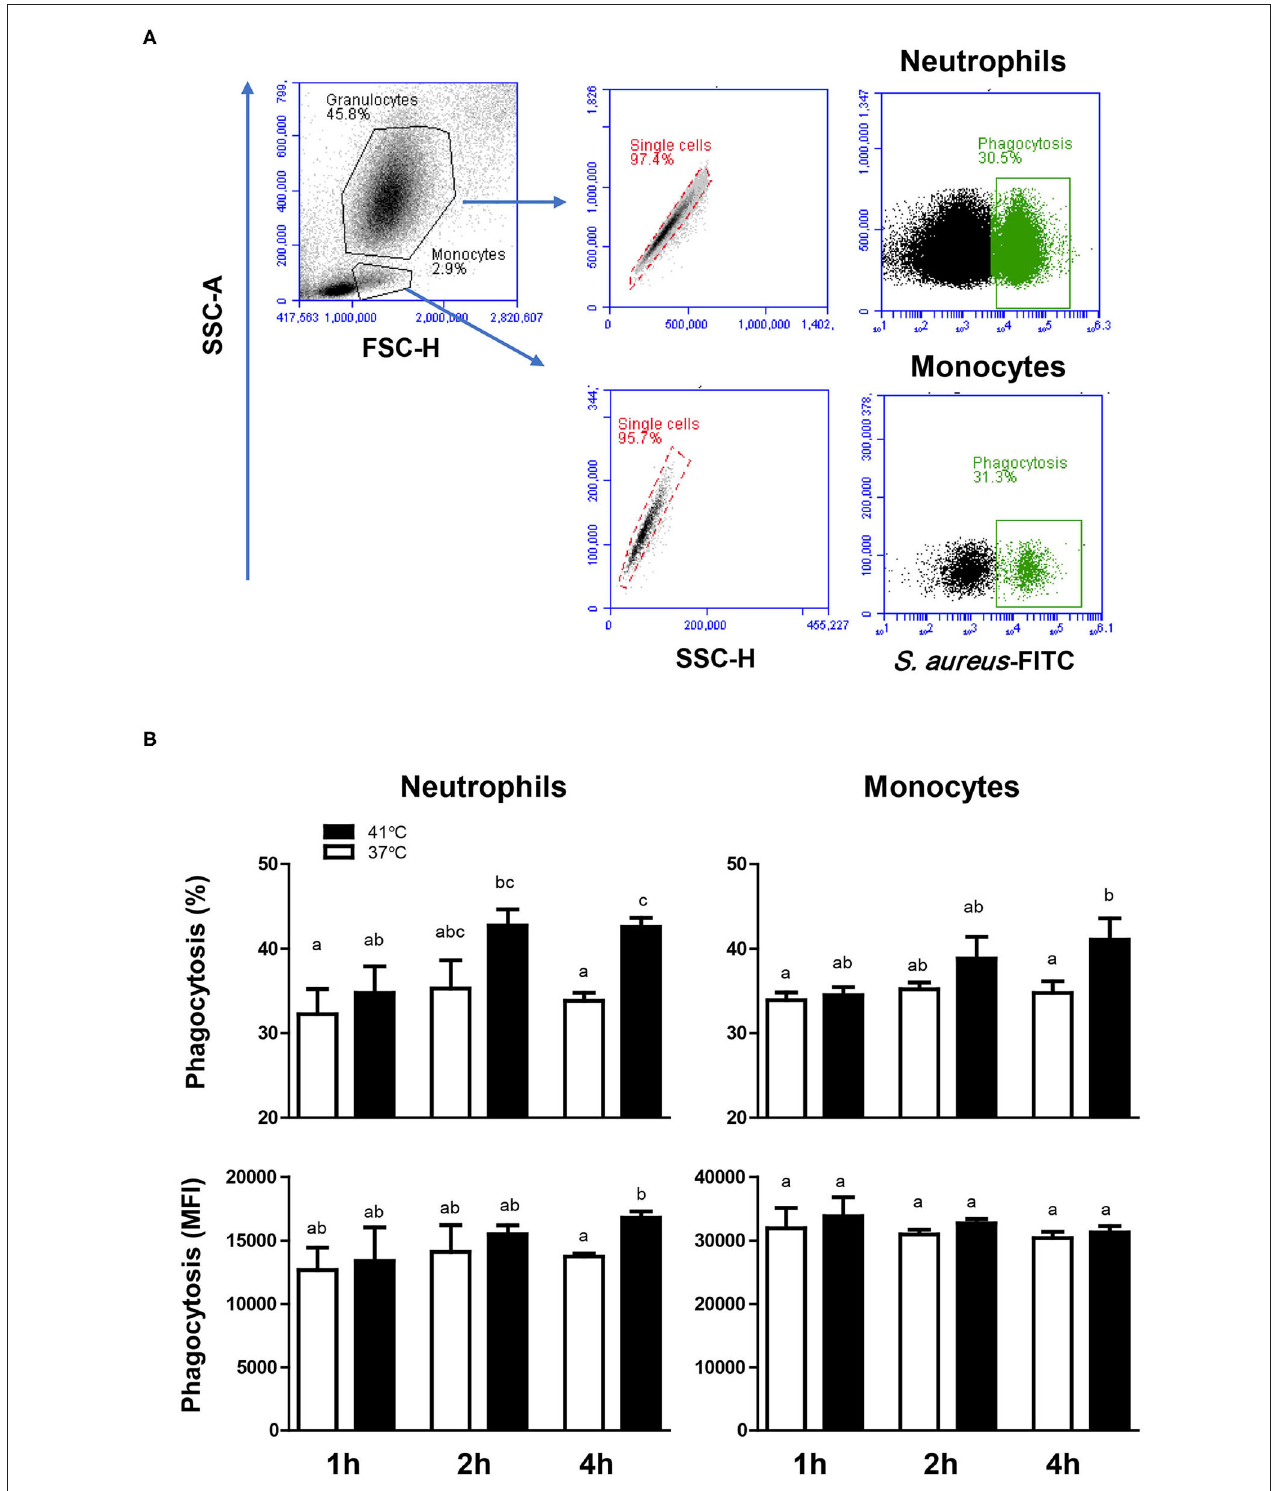
FIGURE 4 | The impact of heat stress on bacterial phagocytosis by camel neutrophils and monocytes. (A) Separated camel leukocytes were incubated with heat-killed FITC-labeled S. aureus bacteria and their phagocytosis activity was analyzed by flow cytometry. After gating on neutrophils and monocytes, the percentage of FITC-positive, phagocytosis-positive cells and the phagocytosis capacity (indicating the number of bacteria phagocytosed by each cell as measured by MFI of phagocytosis-positive cells) were determined for each cell type. (B) Data were presented as means ± SEM for blood incubated at 37 and 41 ◦ C for 1, 2, and 4h. Different lower case letters indicate a significant difference between the groups as analyzed using one-way ANOVA ( p < 0.05).